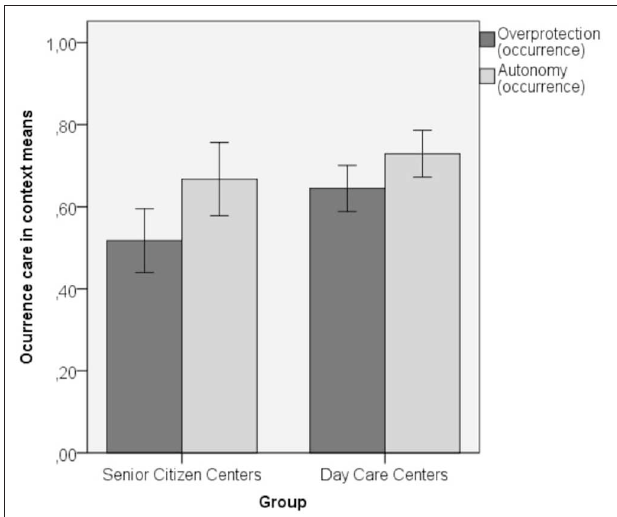
FIGURE 1 | Means and SD of overprotection and autonomy in the occurrence measures.